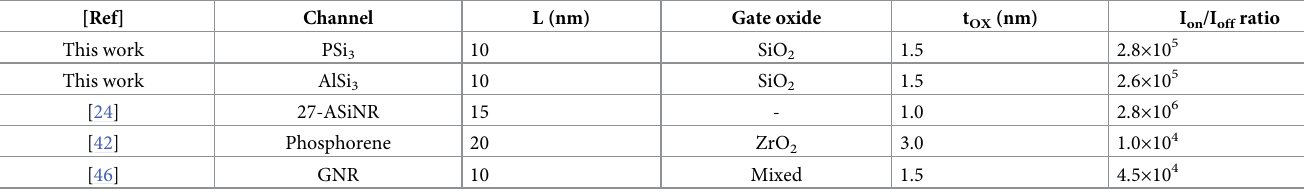
Table 2. Comparison of I